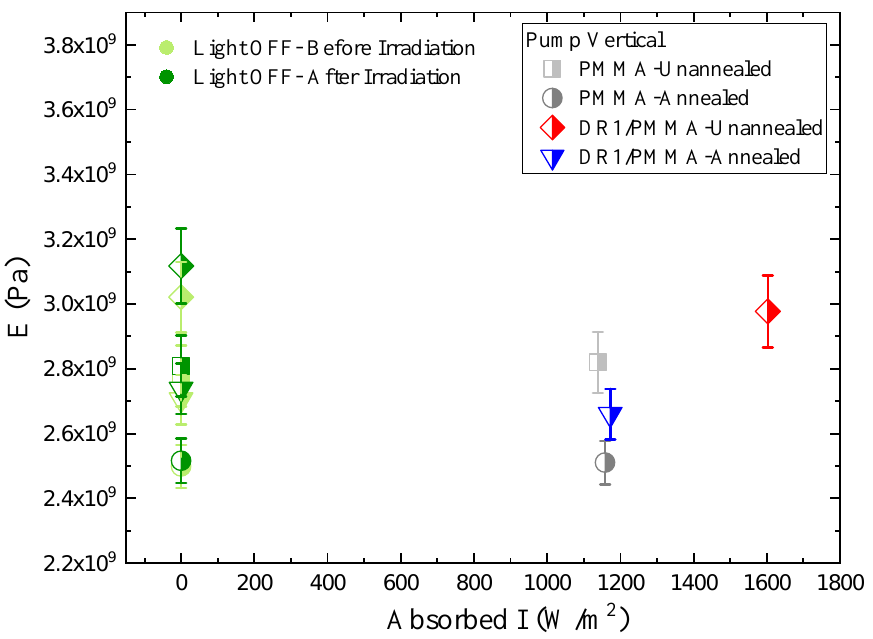
Figure 14. Young’s Modulus for unannealed and annealed PMMA and DR1/PMMA fibers as a function of maximum vertically polarized absorbed pump